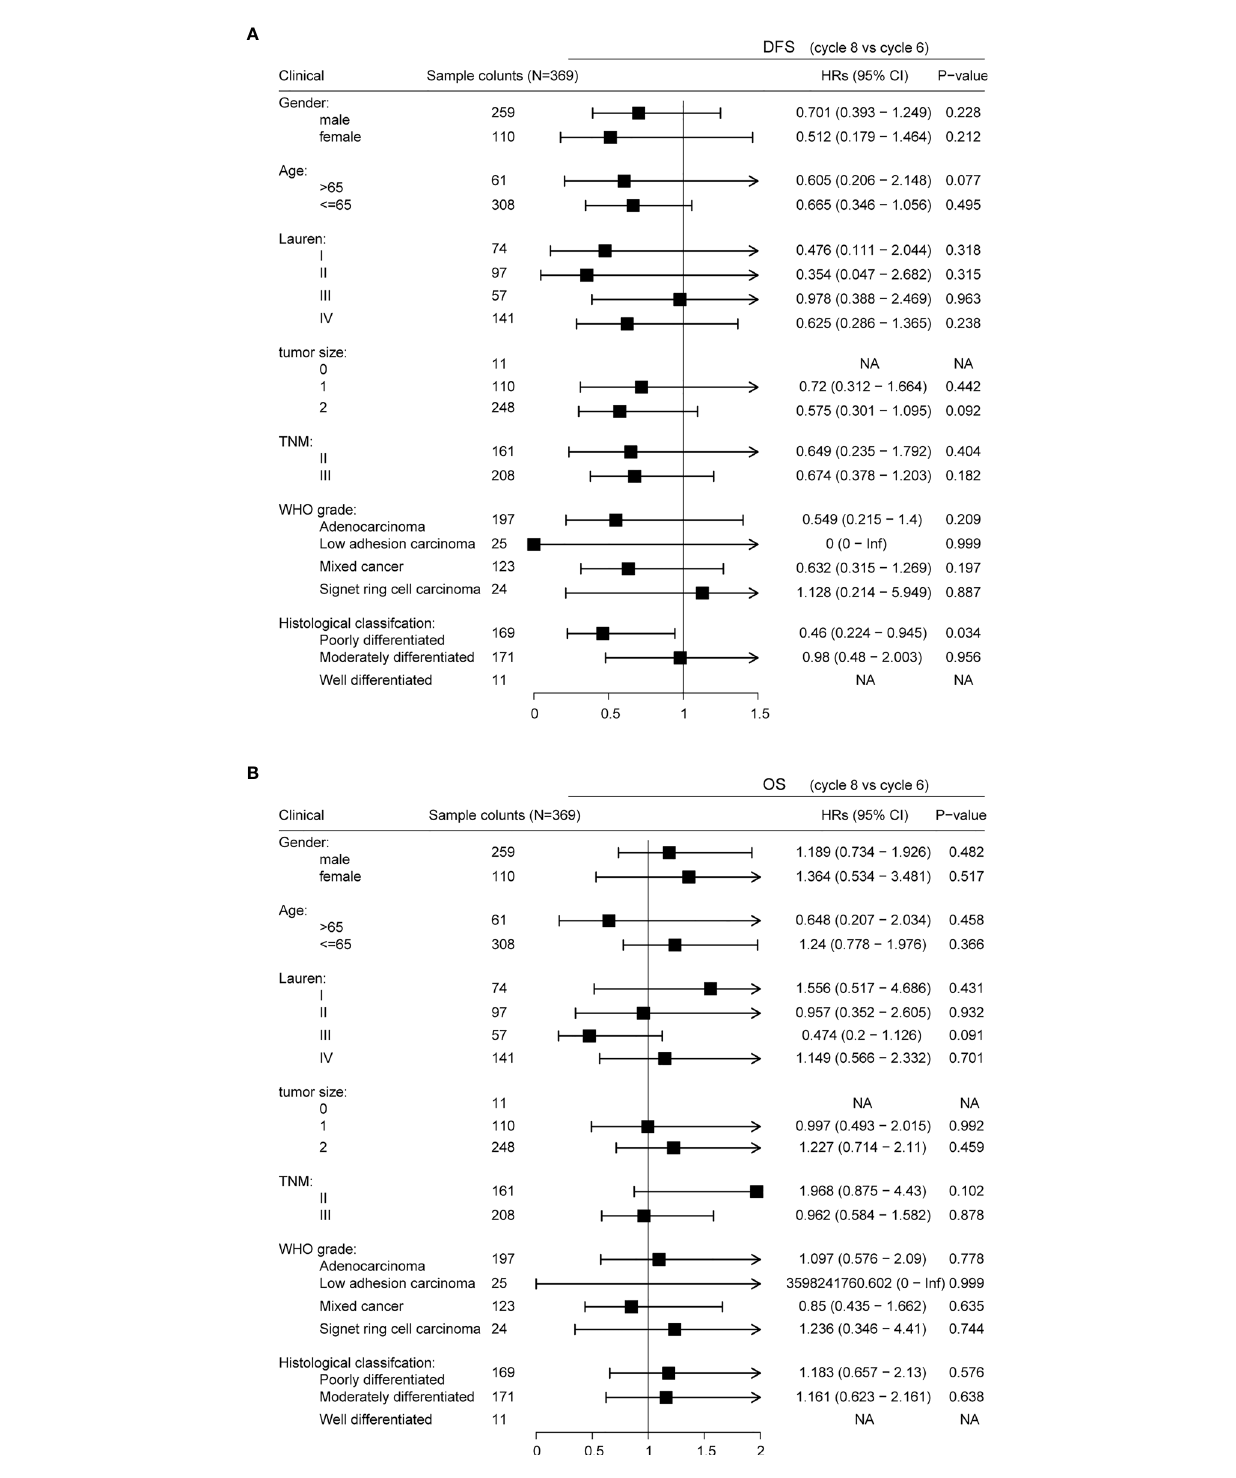
FIGURE 6 | Subgroup analyses of disease-free survival (DFS) (A) and of overall survival (OS) (B)